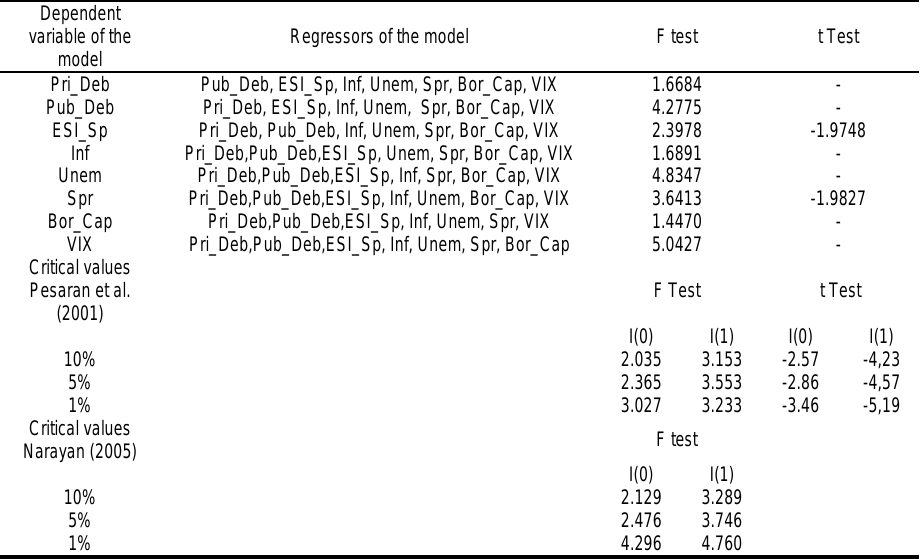
Table 3. Results of bound tests or PSS Dependent variable of